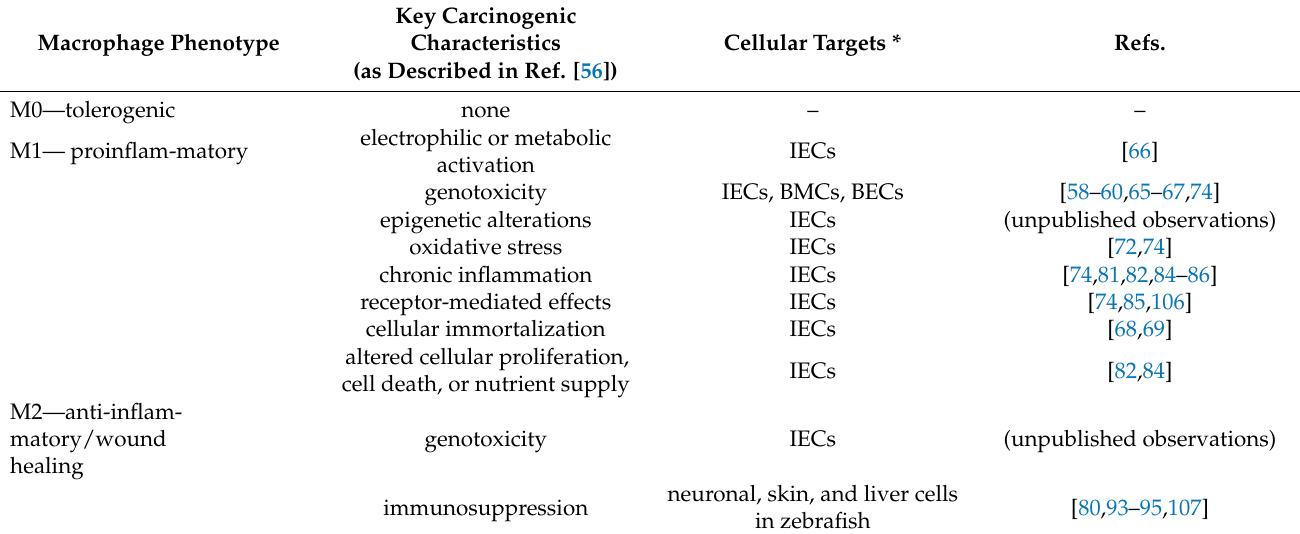
Table 1. Carcinogenic characteristics of polarized